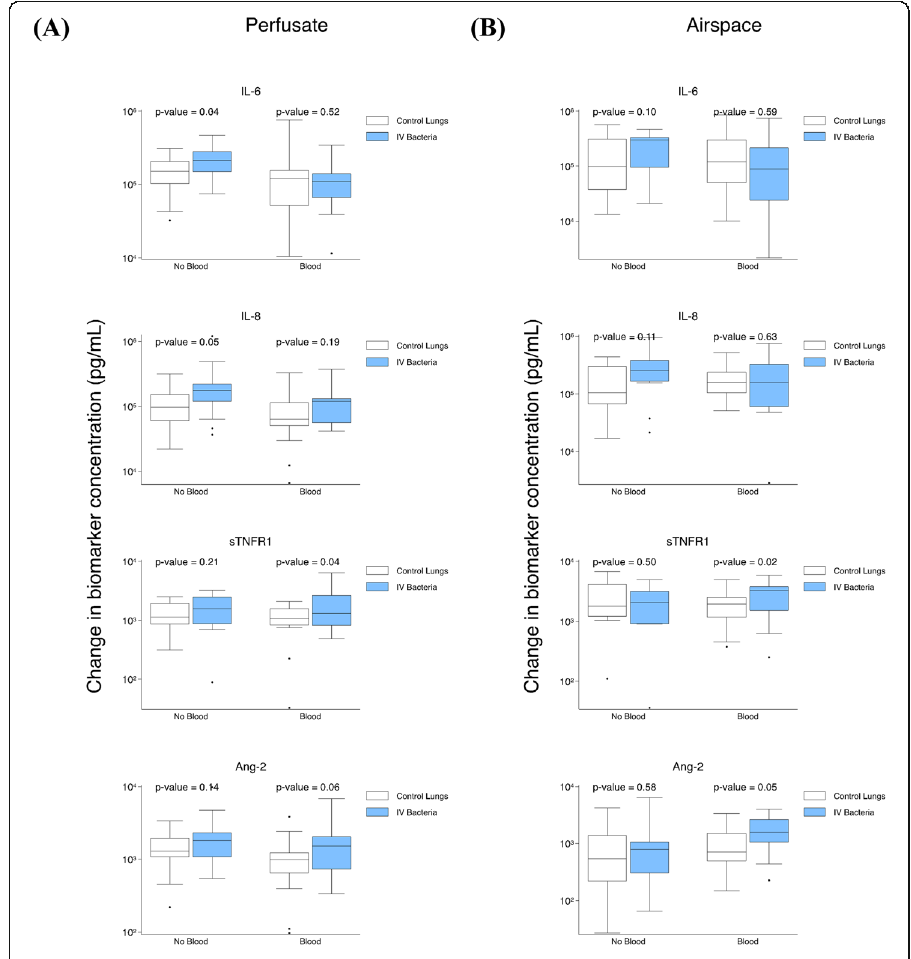
Fig. 4 Impact of IV S. pneumoniae on biomarker change levels after ex vivo lung perfusion. a Comparison of change in perfusate biomarker levels after 4 h of ex vivo perfusion in control lungs ( n = 17) relative to models with IV S. pneumoniae ( n = 22) without blood and in control lungs ( n = 21) relative to models with IV S. pneumoniae ( n = 19) with blood. b Comparison of change in airspace biomarker levels after 4 h of ex vivo perfusion in control lungs ( n = 13) relative to models with IV S. pneumoniae ( n = 14) without blood and in control lungs ( n = 16) relative to IV S. pneumoniae ( n = 13) with